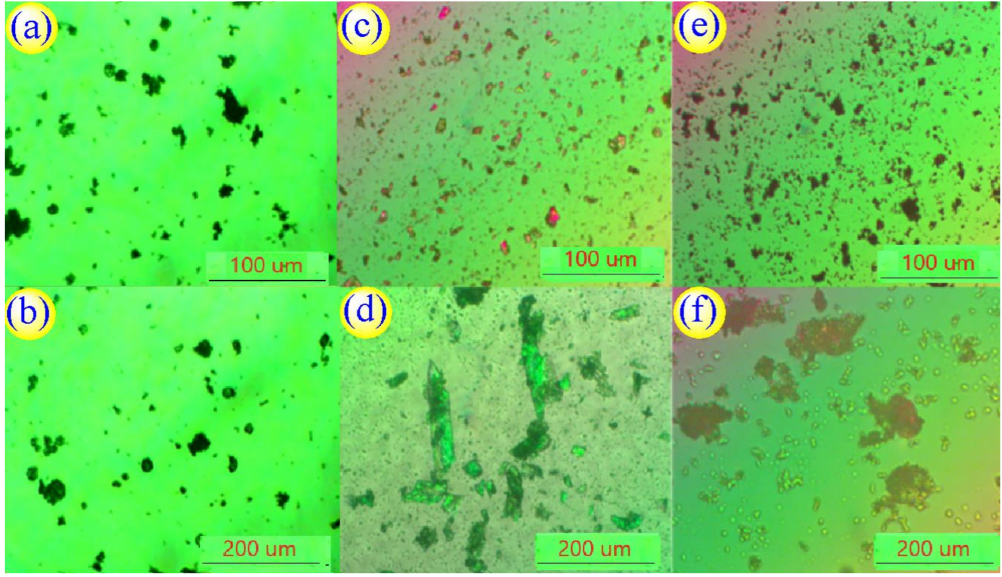
Figure 3. POMimages of ( a , b ) CNC; ( c , d )UPy-NCO; ( e , f